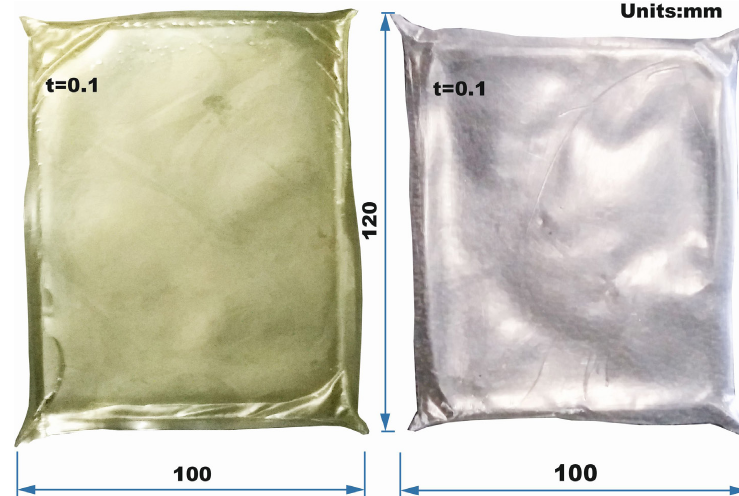
Figure 1. Photographs of the conventional (left) and NaMMT nanocomposite (right) maize starch-based